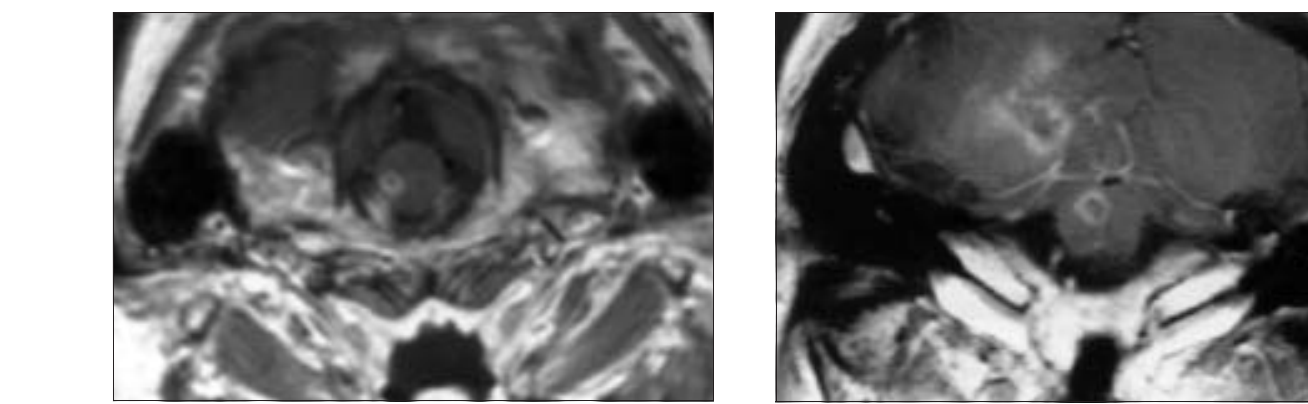
Figure 2) Ring enhancing lesion in the medulla with bilateral medul- lary lesions in magnetic resonance image performed on day